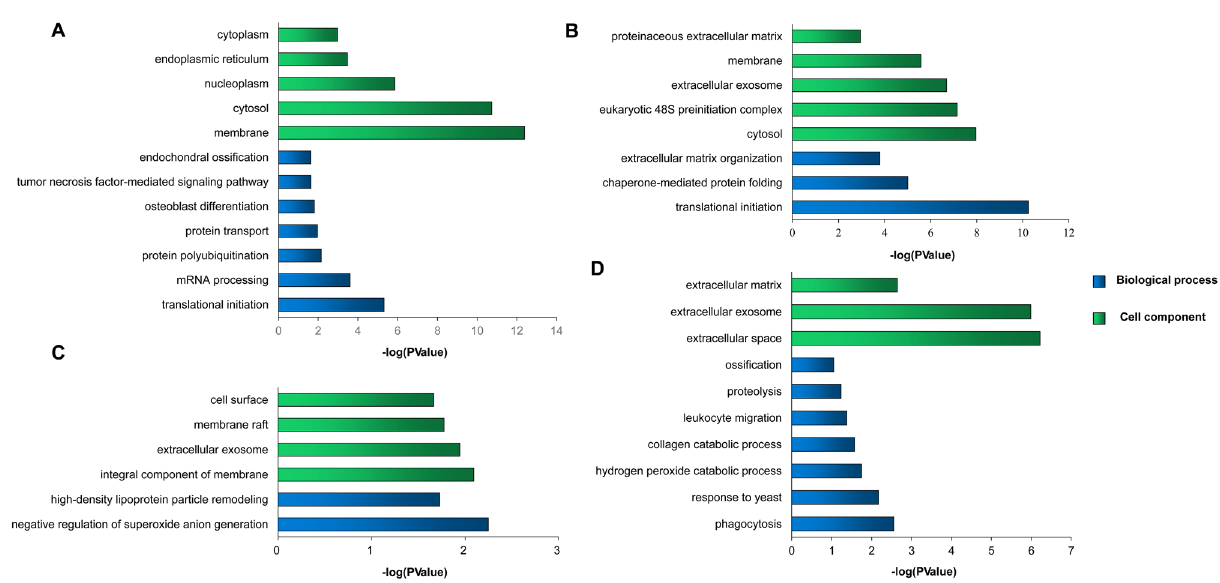
Figure 5. The GO enrichment result for antler stages-special proteins. ( A – D ) respectively represent the results of specific expressed proteins for the first four stages, the first five stages, 100 days and 130